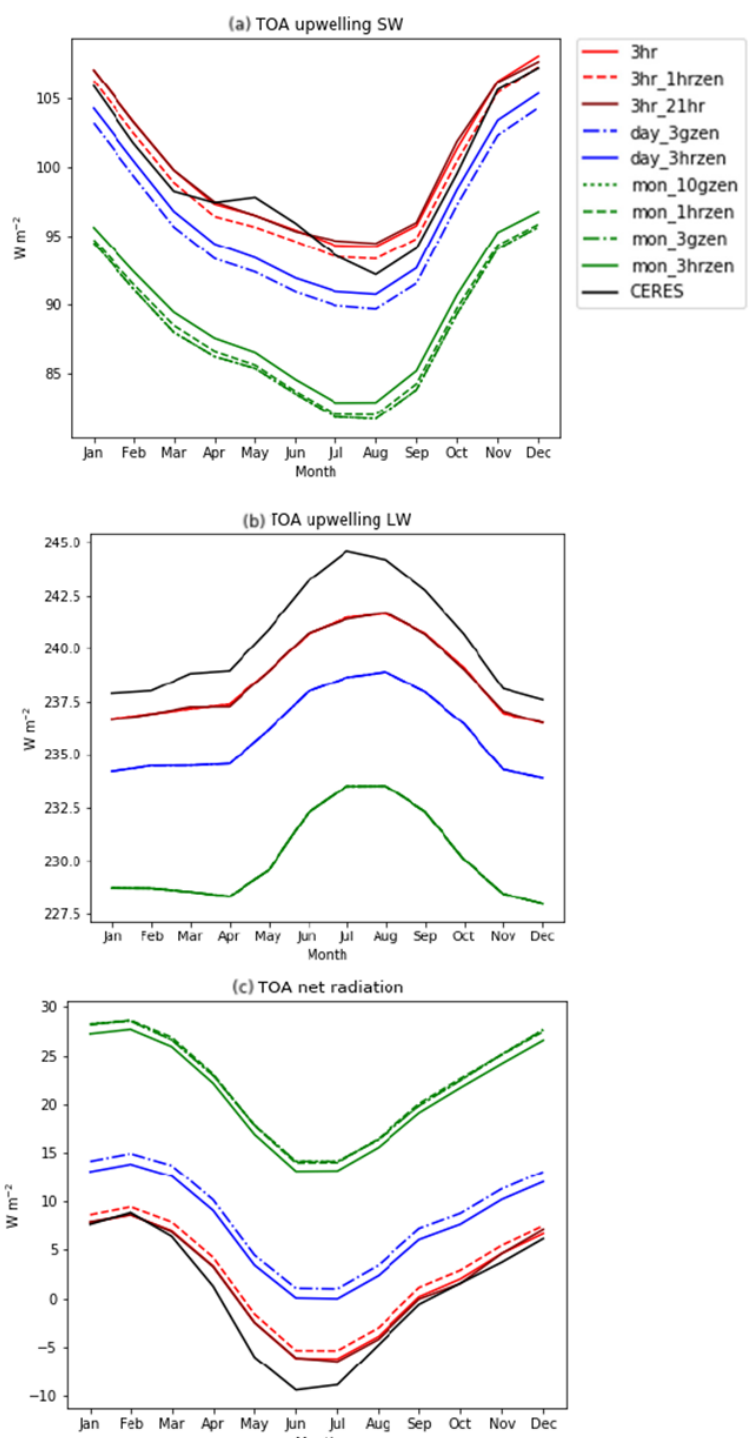
Figure 7. Radiative fluxes calculated by ecRad using 2003 CAMS reanalysis data for the nine time-stepping experiments described in Table 3 (coloured lines): (a) top-of-atmosphere shortwave upwelling radiative flux, (b) top-of-atmosphere longwave upwelling radiative flux, (c) top-of-atmosphere net downwelling radiation. The black line shows the observed radiation fluxes for CERES